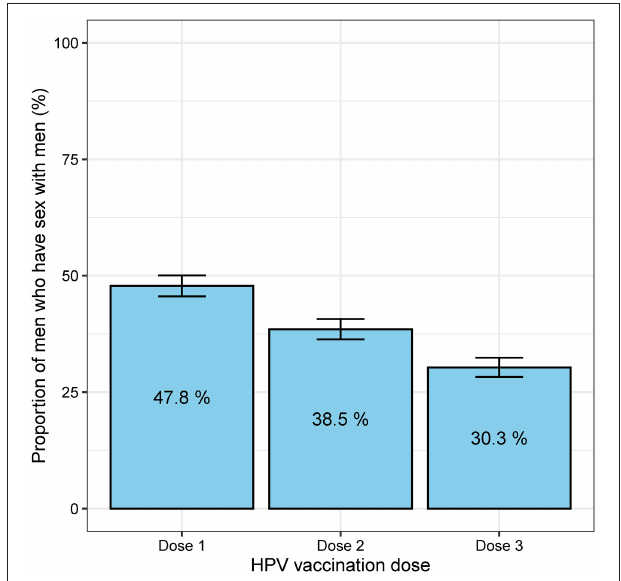
FIGURE 1 | The proportion of 1,947 men who have sex with men who received the first, second and third doses of HPV vaccine. The error bars represent the 95% confidence intervals of the proportion .